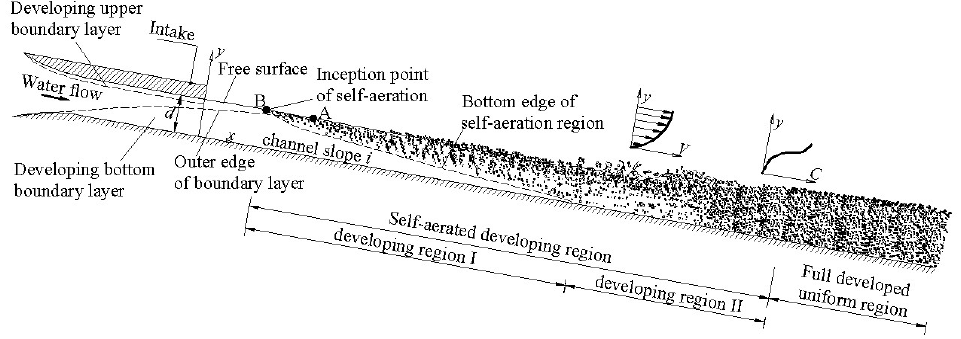
Figure 1. The region of self-aerated developing flow.